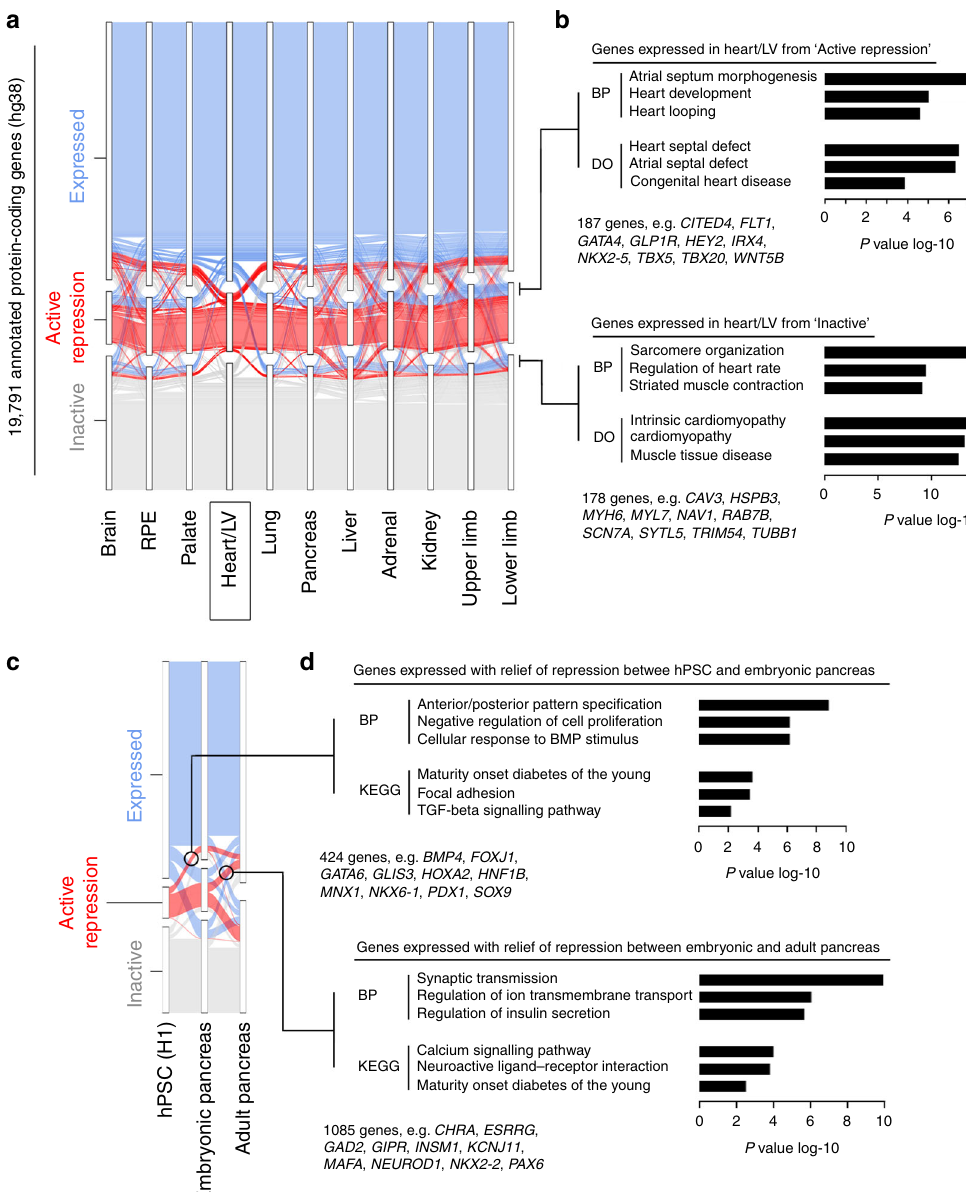
Fig. 3 Integration of promoter states across tissues and over time. a Alluvial plot showing promoter state for 19,791 annotated genes across all tissues with replicated datasets. To aid visualisation, all the different transcribed states are amalgamated into a single expressed category (the alluvial plot for all individual states is shown in Supplementary Fig. 6). The example shown is centred on the promoter state in the Heart/LV dataset. Those genes with an expressed promoter state in the heart and either active repression or inactive elsewhere are indicated to the right of the panel and subject to gene enrichment analyses in ( b ). b Gene enrichment analysis of genes with an expressed promoter state in the heart and either active repression or inactive in all remaining tissues. All remaining genes were used as background. Examples of the genes underlying the biological process (BP) or disease ontology (DO) terms and their total number are listed beneath the bar charts. c Alluvial plot showing the variance in promoter state between H1 human pluripotent stem cells (hPSCs), the embryonic pancreas (prior to endocrine differentiation 24 ) and the adult pancreas. Circles capture those genes that shift from active repression to expressed at the stage of either embryonic or adult pancreas. d Gene enrichment analyses of encircled genes from ( c ). Examples of the genes underlying the BP and KEGG terms and their total number are listed beneath the bar charts. All remaining genes were used as background. While maturity onset diabetes of the young emerged in both analyses, the underlying genes were different re fl ecting developmental roles prior to or after pancreatic endocrine differentiation 24 promoters of genes controlling cell fate decisions, but not dif- To scrutinise regulatory changes temporally, we focussed on ferentiated function. Moreover, the fact that these cell fate genes pancreas and included datasets from human pluripotent stem did not emerge for any tissue in the sub-categorisation of cells (hPSCs) and adult tissue. Different sets of repressed genes H3K27me3 signal with low-level H3K4me3 (Supplementary lost their H3K27me3 mark to become expressed as cells Figs. 6 – 11) further supports lack of bivalency at their gene transitioned from pluripotency to embryonic pancreatic progeni- promoters. tors or from pancreatic progenitors to mature pancreas (Fig. 3c;